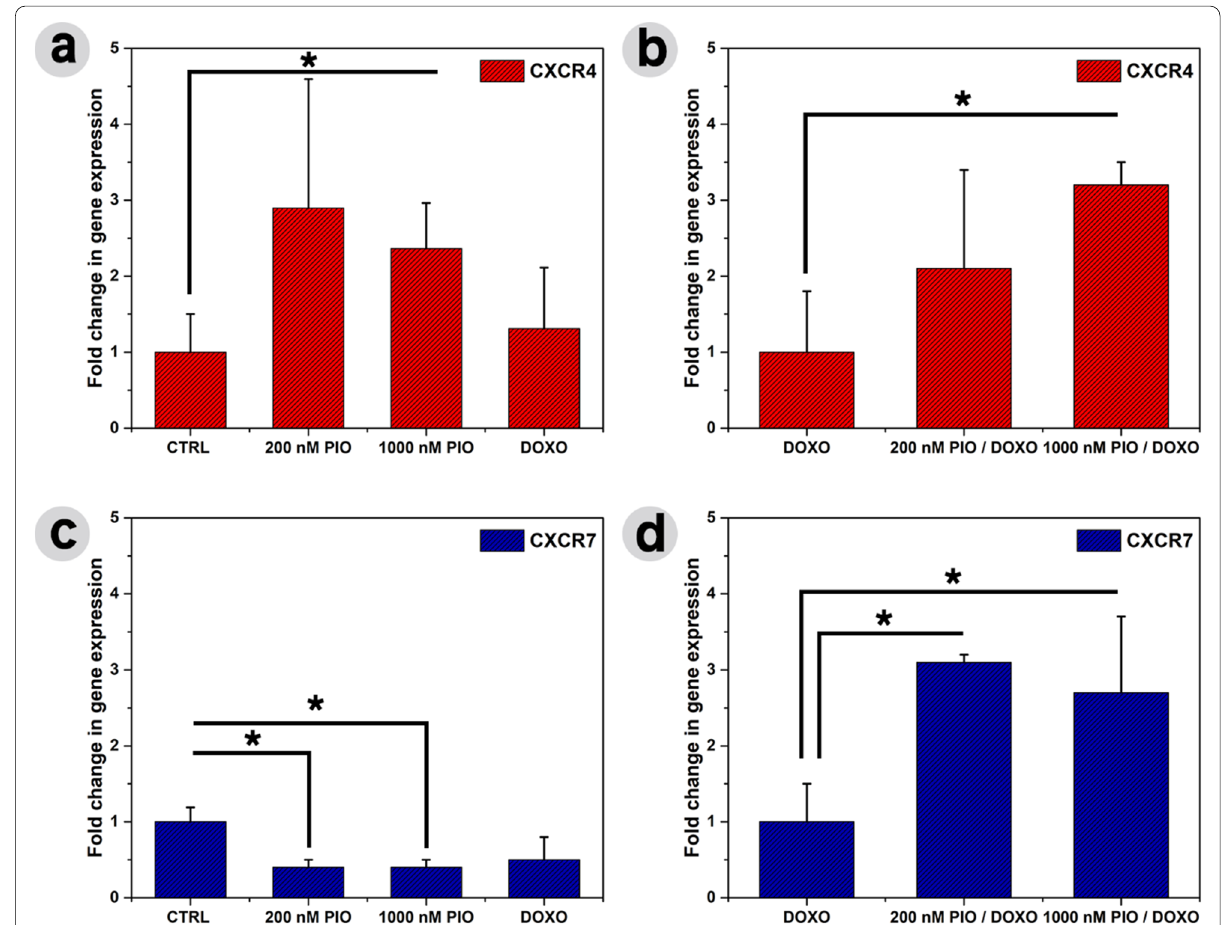
Fig. 1 Evaluation of pioglitazone effects on CXCR4 and CXCR7 gene expression after 21 days. a The CXCR4 gene expressions among control groups as well as DOXO-treated cells ( P 0.049). b The CXCR4 gene expressions in cells receiving DOXO with each dose of PIO simultaneously which = compared with cells treated with DOXO alone ( P 0.046). c The CXCR7 gene expressions among control groups as well as DOXO-received cells ( P = 0.049). d The CXCR7 gene expressions in cells receiving DOXO with each dose of PIO simultaneously which compared with DOXO-treated cells = alone ( P =